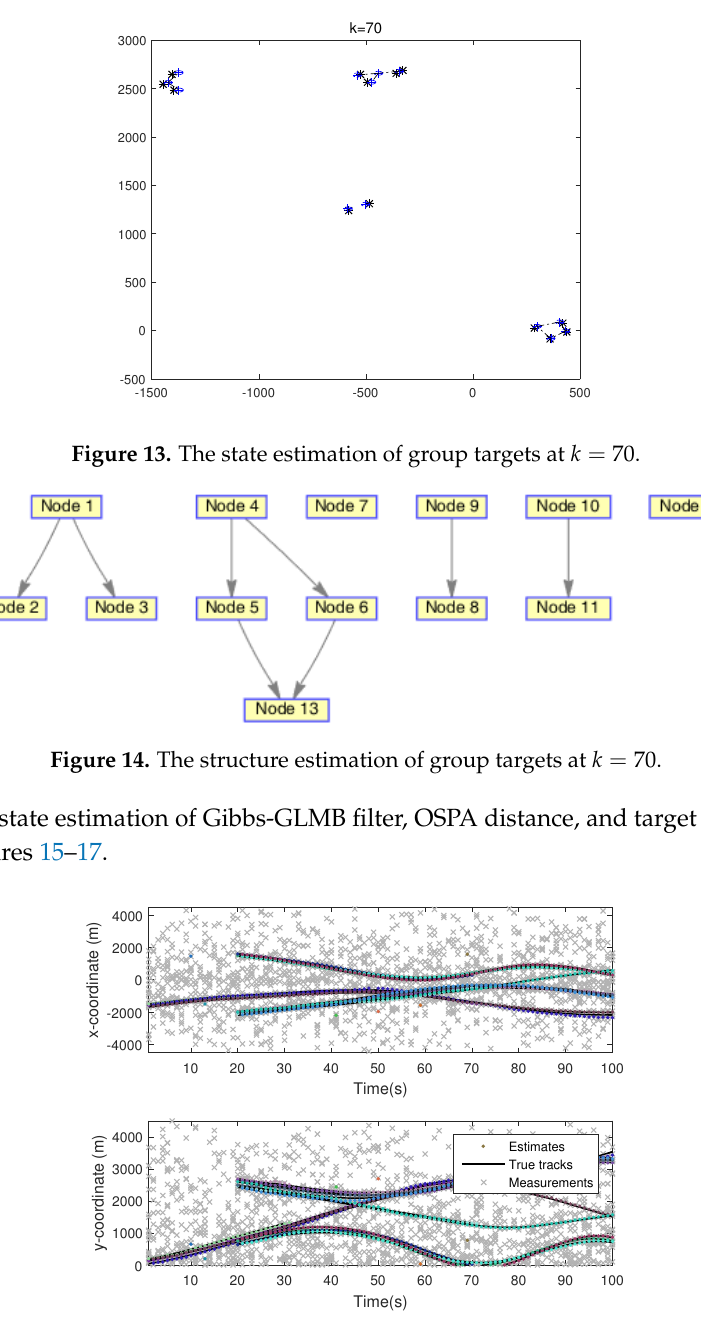
Figure 15. The state estimation by Gibbs Generalized Labeled Multi-Bernoulli (GLMB)